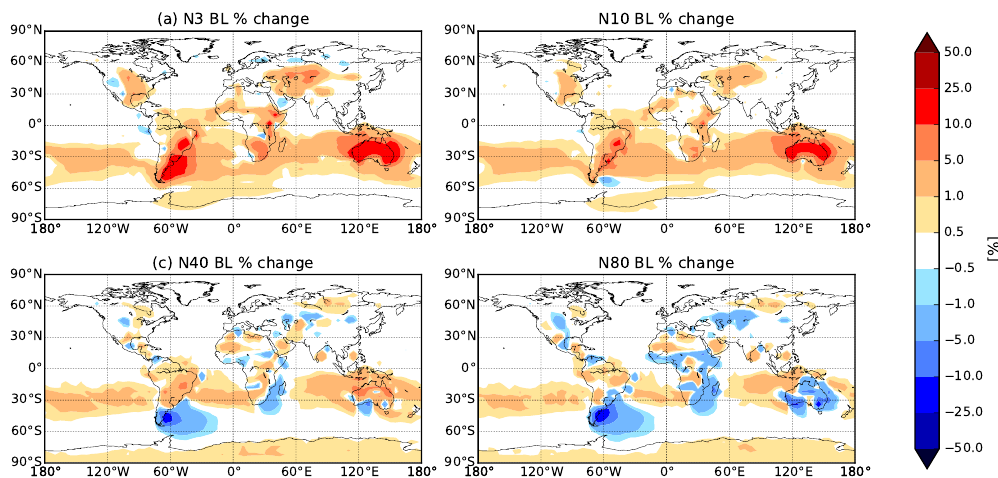
Figure 8. Percentage change in annually averaged boundary layer (a) N3, (b) N10, (c) N40, and (d) N80 when changing MEGAN BVOC emissions from year 1000 to year 2000 with constant present-day anthropogenic emissions (2005) including an additional 100TgSOAyr − 1 as per D’Andrea et al. (2013) (BE2.XSOA–BE1.XSOA). Globally averaged, N3, N10, and N40 increased by 1.9, 1.2, and 0.3%, respectively, whereas N80 decreased by 0.3% (see Table 2). An increase in particle number concentration is represented in red, and a decrease in blue.